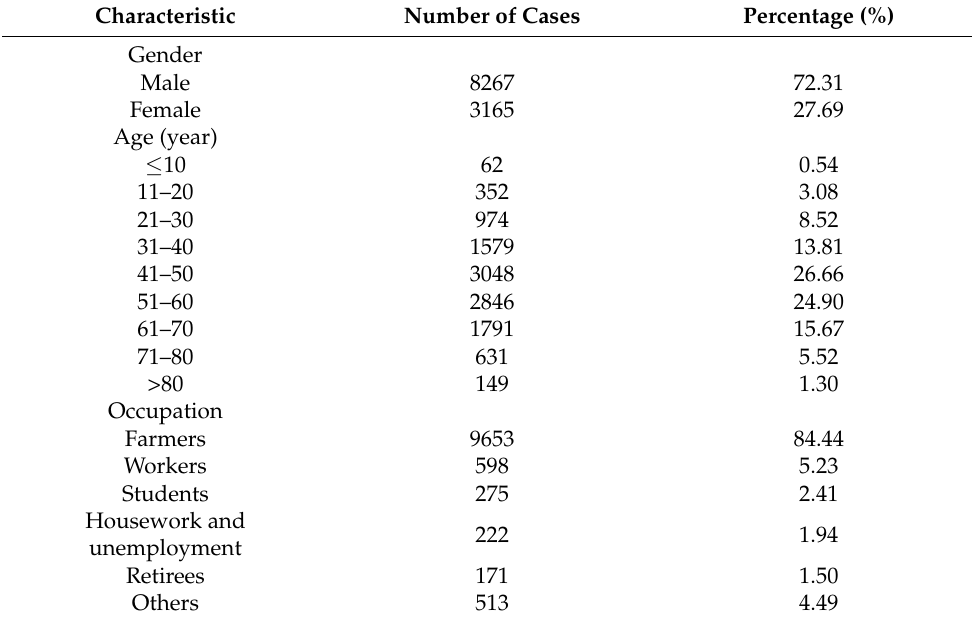
Table 1. Demographic characteristic of HFRS cases in Shandong Province from 2010 to 2018.